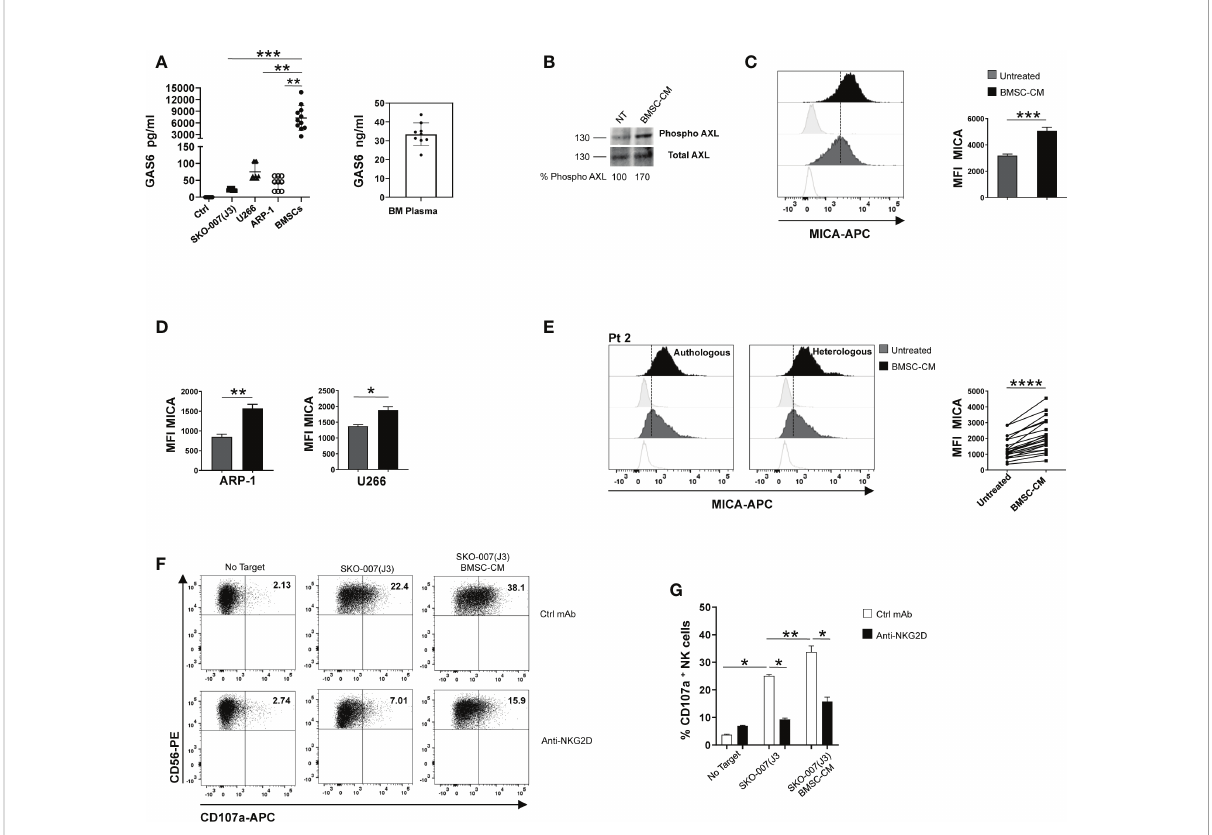
FIGURE 3 BMSC-CM up-regulates MICA surface expression in MM cells. GAS6 protein was quanti fi ed by ELISA in conditioned medium (CM) derived from the indicated MM cell lines, BMSCs and plasma from BM aspirates of MM patients. Serum free medium was used as control (Ctrl) (A) . Total protein extracts obtained from SKO-007(J3) untreated or treated for 1h with BMSC-CM were analyzed for phosphorylated and total AXL expression by Western Blot (B) . Numbers represent densitometric analysis of phosphorylated AXL normalized relative to untreated cells. MICA surface expression was analyzed by fl ow cytometry in SKO-007(J3) (n=8) (C) , ARP-1 (n=6) or U266 (n=5) MM cell line (D) or in primary malignant PCs (n=12) (E) untreated or treated with BMSC-CM for 72h or 48h, respectively. A representative experiment is shown. Histograms represent the MFI of speci fi c mAb subtracted of MFI of isotype control. Data show mean ± SD ( ****p < 0.001; ***p < 0.005; **p < 0.05; Mann -Whitney Test). NK cells derived from healthy donor PBMCs were incubated with SKO-007(J3) cells, untreated or cultured for 72h with BMSC- CM and used as target cells in a degranulation assay as described above. Results are expressed as the percentage of CD107a + NK cells (F) . A representative experiment is shown in (E) . Histogram represents the mean ± SD from three independent experiments (G) (*p < 0.05; **p < 0.001